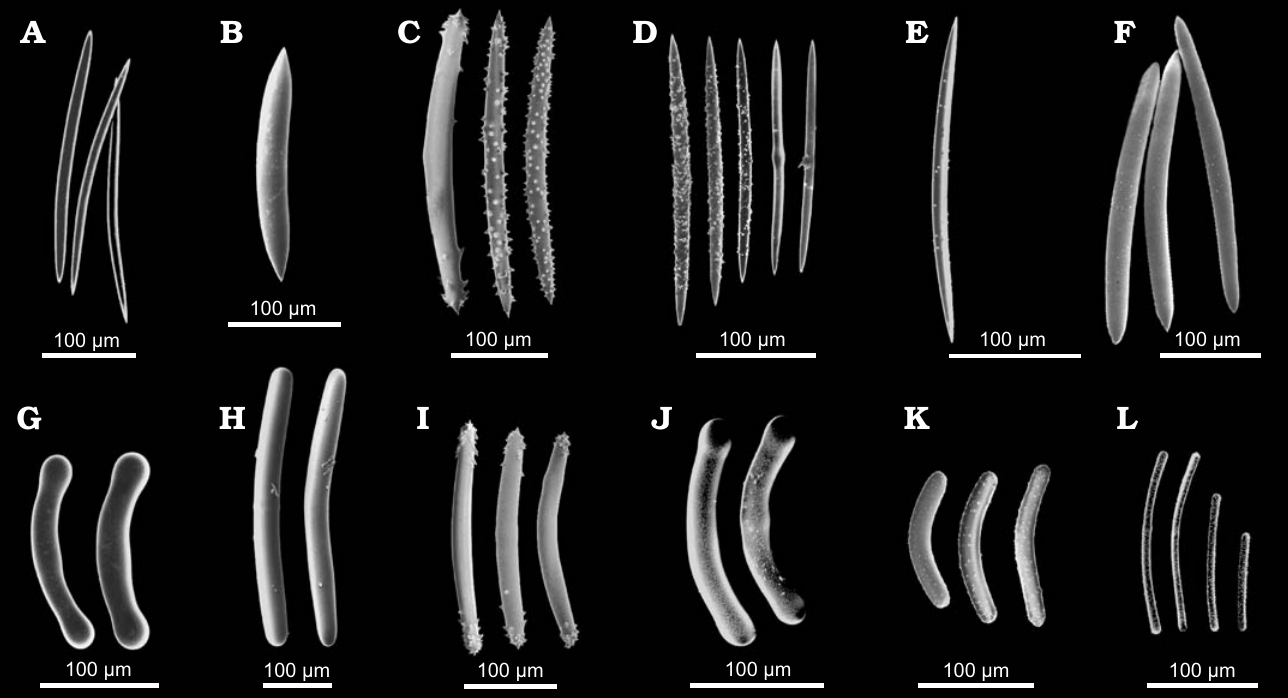
Fig. 2. Morphology of megascleres of Recent freshwater sponges of the order Spongillida. A – F . Oxeas. A . Spongilla lacustris (Linnaeus, 1759), Palae- arctic-Nearctic Region, slim smooth oxeas. B . Drulia browni (Bowerbank, 1863), Neotropical Region, stout smooth oxeas. C . Lubomirskia baikalensis (Pallas, 1771), Palaearctic Region, spiny oxeas. D . Makedia tanaensis Manconi, Cubeddu, and Pronzato, 1999, Afrotropical Region, variously spiny slim oxeas. E . Anheteromeyenia argyrosperma (Potts,1880), Nearctic Region, irregularly micro-spiny oxea. F . Cortispongilla barroisi (Topsent, 1892), Palaearctic Region, irregularly micro-granulated oxea. G – L . Strongyles. G . Potamolepis marshalli Burton, 1938, Afrotropical Region, smooth, stout strongyles with inflated tips. H . Sterrastrolepis brasiliensis Volkmer-Ribeiro and De Rosa Barbosa, 1978, Neotropical Region, smooth strongyles. I . Baikalospongia ba- cillifera Dybowsky, 1880, Palaearctic Region, strongyloxeas with hooked tips. J . Potamolepis micropora Burton, 1938, Afrotropical Region, strongyles with microspines and inflated tips. K . Swartschewskia papyracea (Dybowsky, 1880), Palaearctic Region, spiny strongyles. L . Nudospongilla cunningtoni (Kirkpatrick, 1906), Afrotropical Region, spiny, slim strongyles. SEM images. Modified from Manconi and Pronzato (2002, 2009).